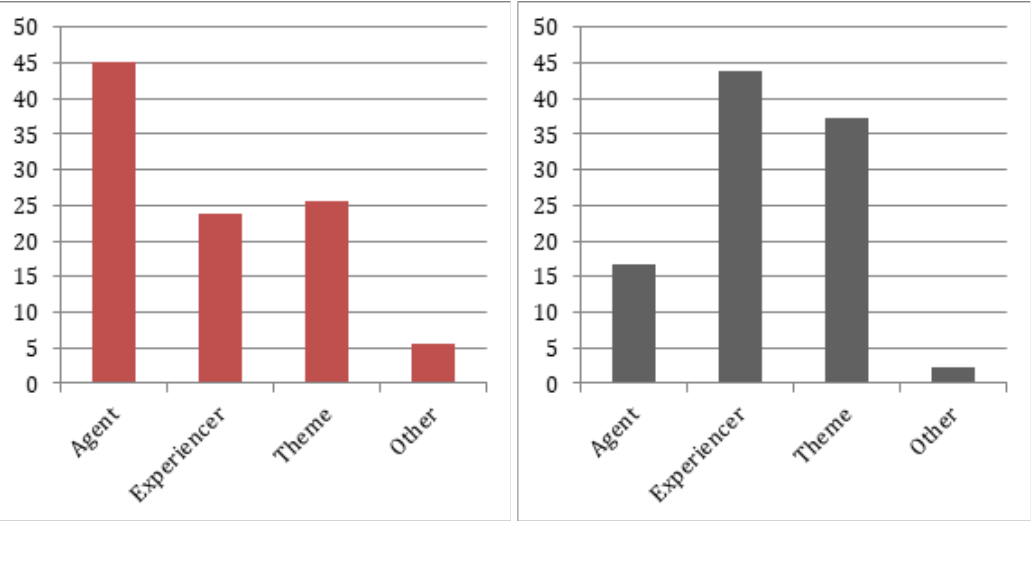
Figure 1: Relative thematic roles associated with the narrator by novel, in percentages of the novel’s total distribution. Left: De wijde blik , right: Specht en zoon .